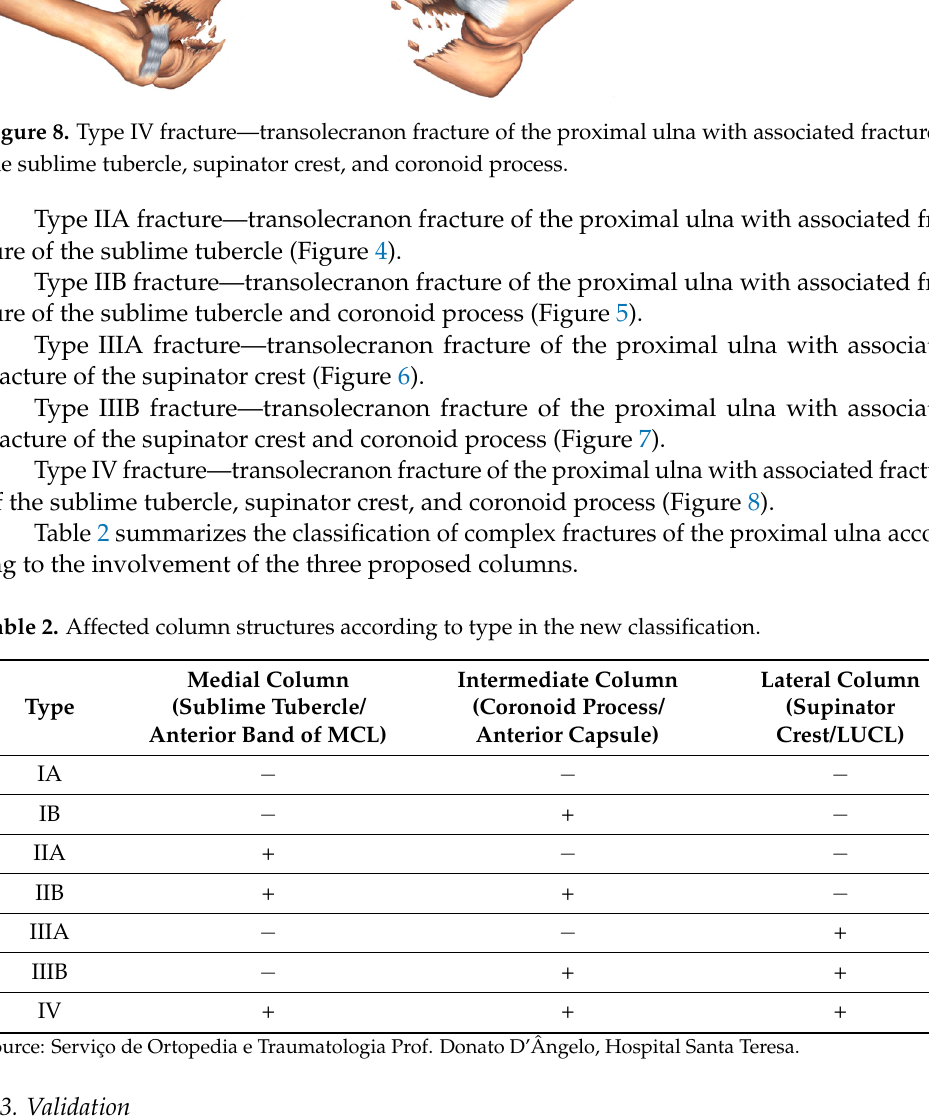
Figure 7. Type IIIB fracture—transolecranon fracture of the proximal ulna with associated fracture of the supinator crest and coronoid process.